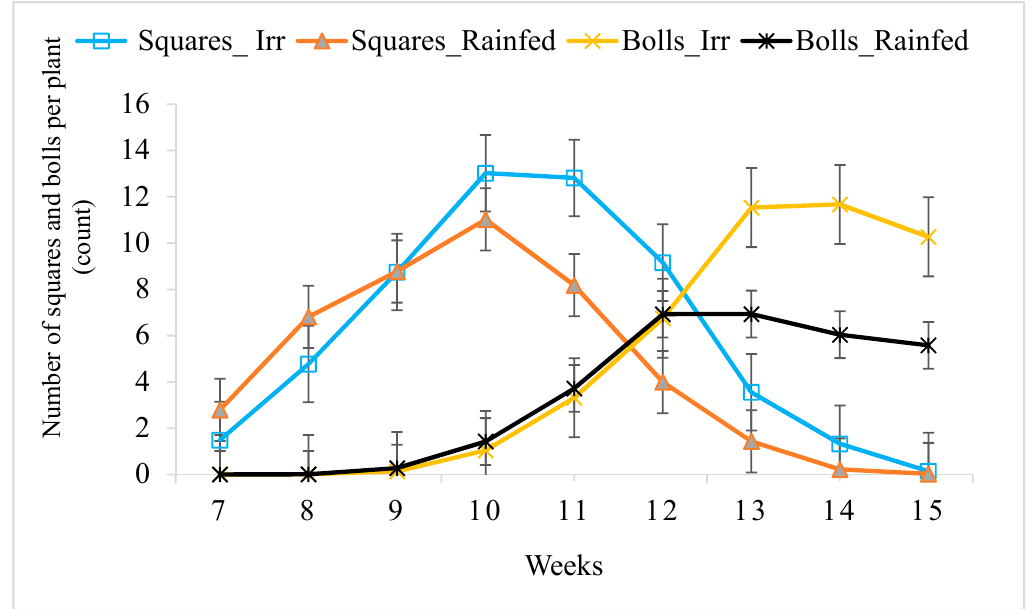
Figure 1. The average number of squares and bolls per plant distribution by week for upland cotton lines grown under irrigated and rainfed conditions. Data for agronomic traits were collected for nine consecutive weeks (weeks 7 to 15). Data averaged for three years, nine genotypes, and over four replications. Standard error (SE) bars were used to show the variations between irrigated and rainfed trials. Overlapping SE bars show no significant differences between irrigated and rainfed treatments.